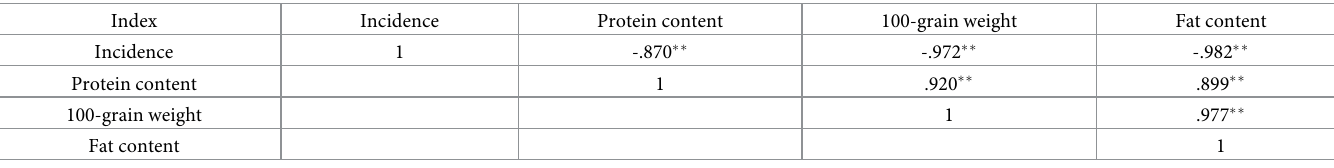
Table 1. Coefficients of correlation between the incidence of root rot and protein content, 100-grain weight and fat content.